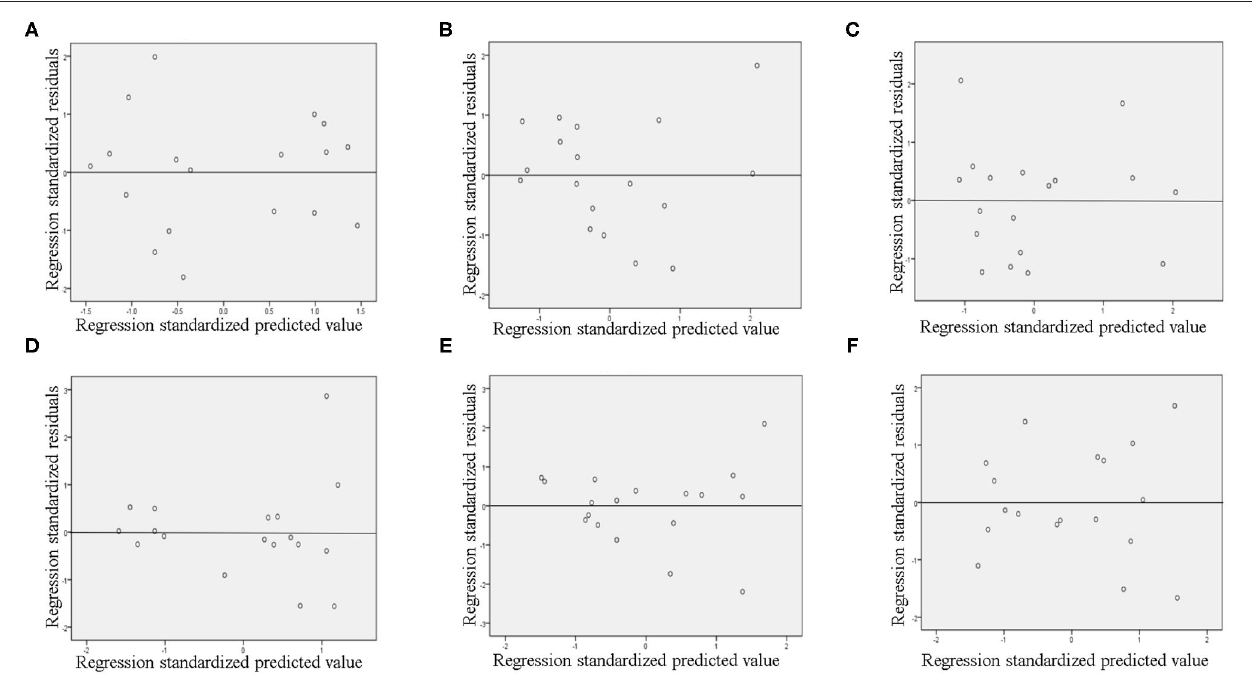
FIGURE 5 | The scatter plot of regression standardized predicted values and regression standardized residuals in Wuhan (A) , Xiaogan (B) , Huanggang (C) , Suizhou (D) , Jingzhou (E) , and Huangshi (F) .